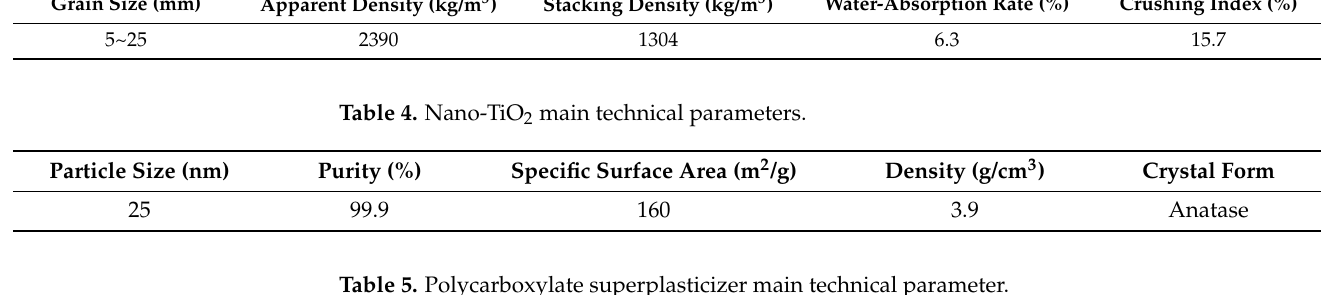
Table 5. Polycarboxylate superplasticizer main technical